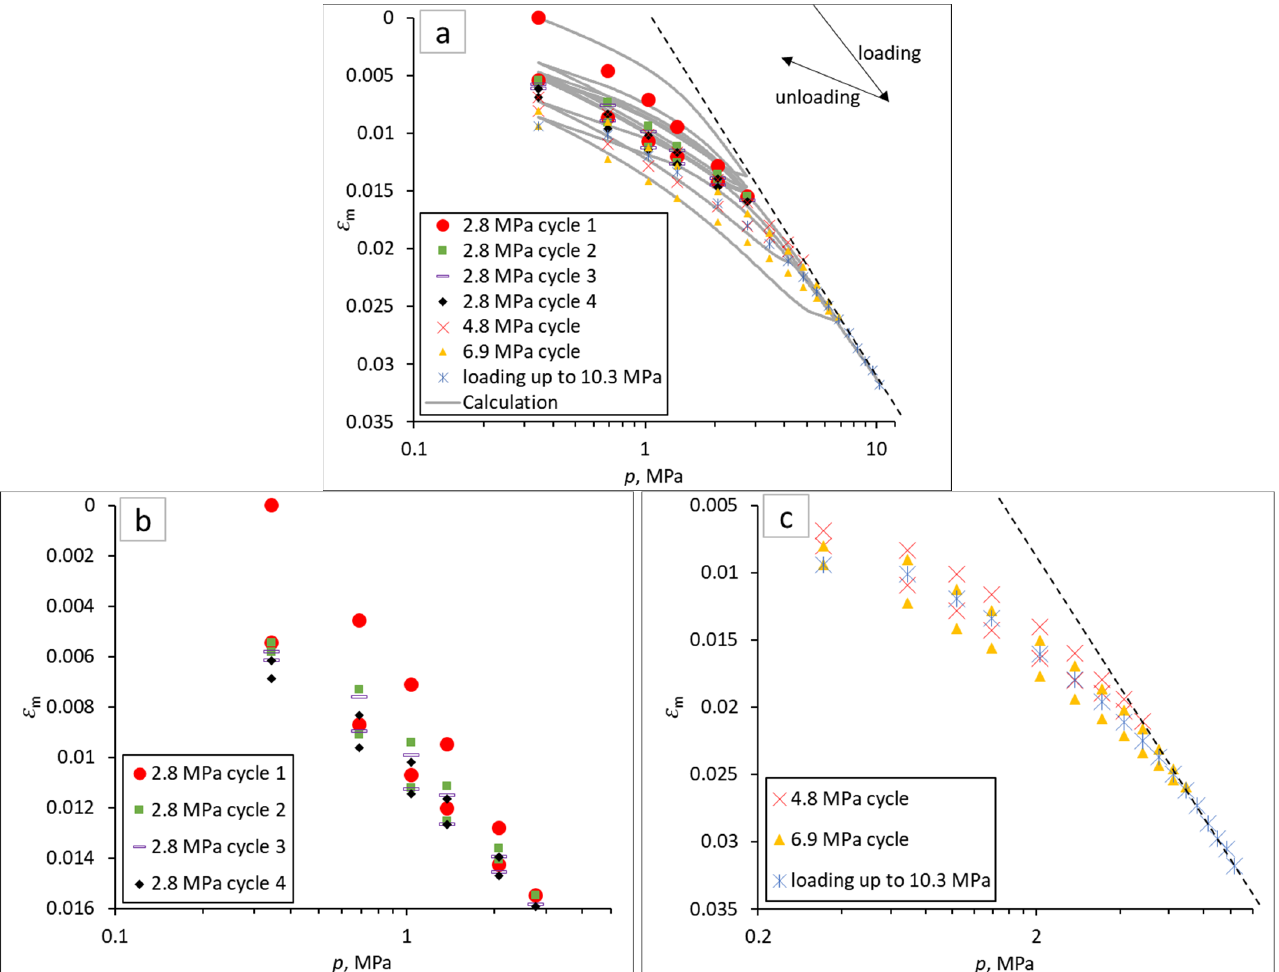
Figure 13. The complete stress–strain path in the test 4: top ( a ): complete data points, bottom ( b ): cycles with peak stress of 2.8 MPa, bottom ( c ): sequential cycles with peak stress of 4.8, 6.9 and 10.3 MPa.